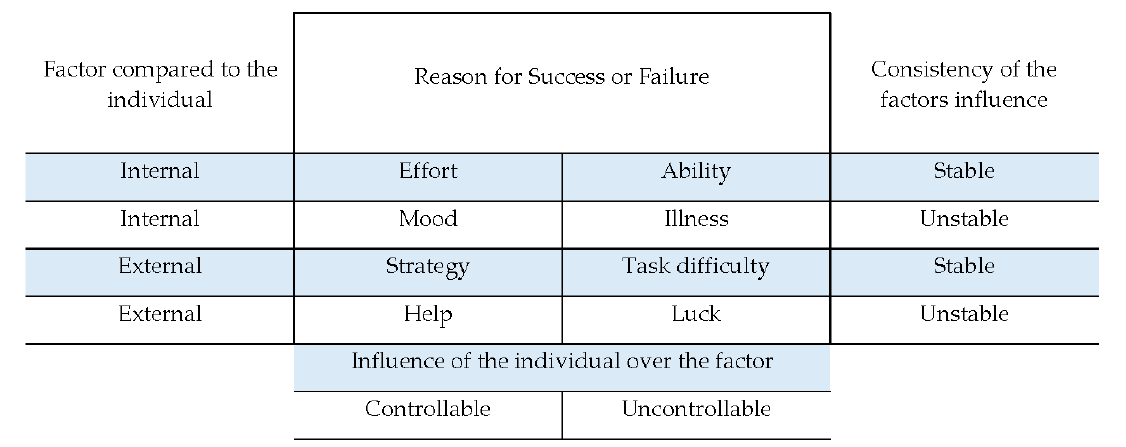
Figure 1. Attribution theory reasons for success or failure.